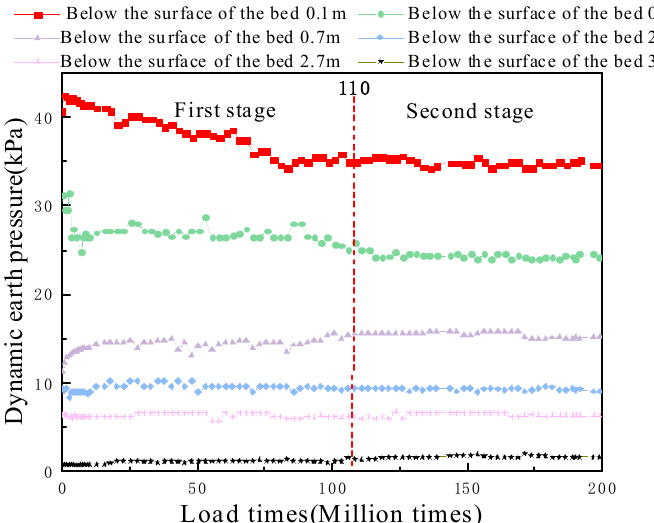
Figure 12. Plots of soil pressure with the number of vibrations—center depth of the left line track.